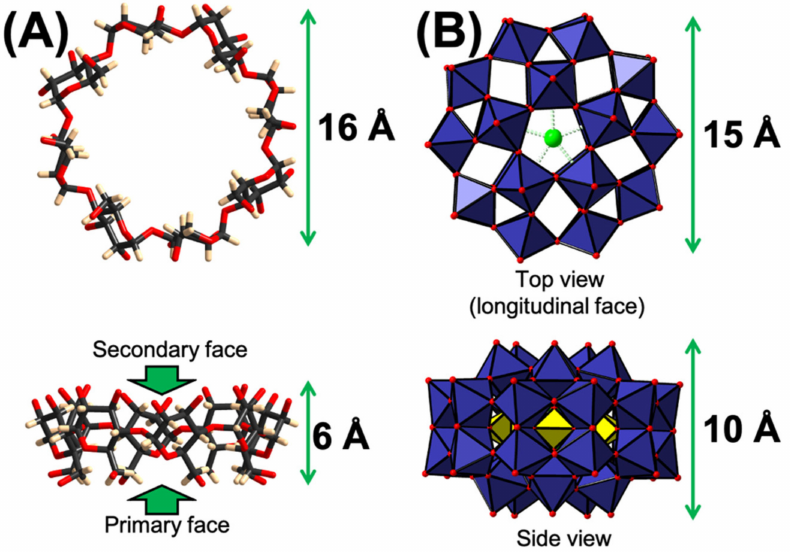
Figure 1. ( A ) Structural representations of the molecular entities used as building blocks. ( A ) γ - cyclodextrin C 48 H 80 O 40 ( γ -CD) resulting from the condensation of eight glycopyranose units. The toroidal macrocycle presents two distinct faces, a smaller one delimited by 8 methoxy groups (primary) and a wider one (secondary) delimited by 16 hydroxyl groups. ( B ) The Preyssler anion [NaP 5 W 30 O 110 ] 14 − with oblate spheroid shape presents two main (longitudinal) faces perpendicular to the virtual C 5 symmetry